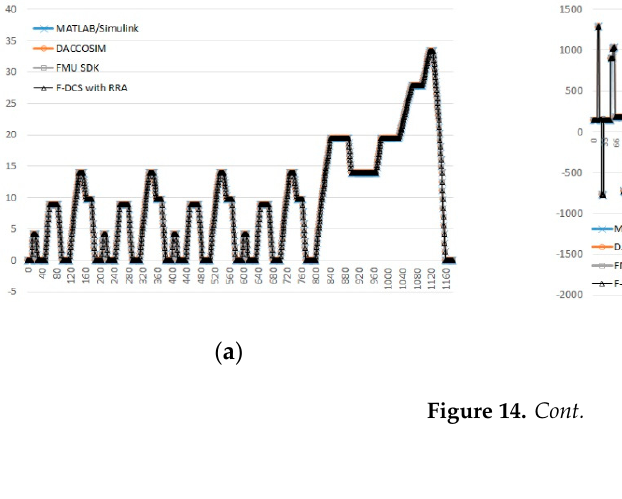
Table 1. EV simulation parameter setting values.